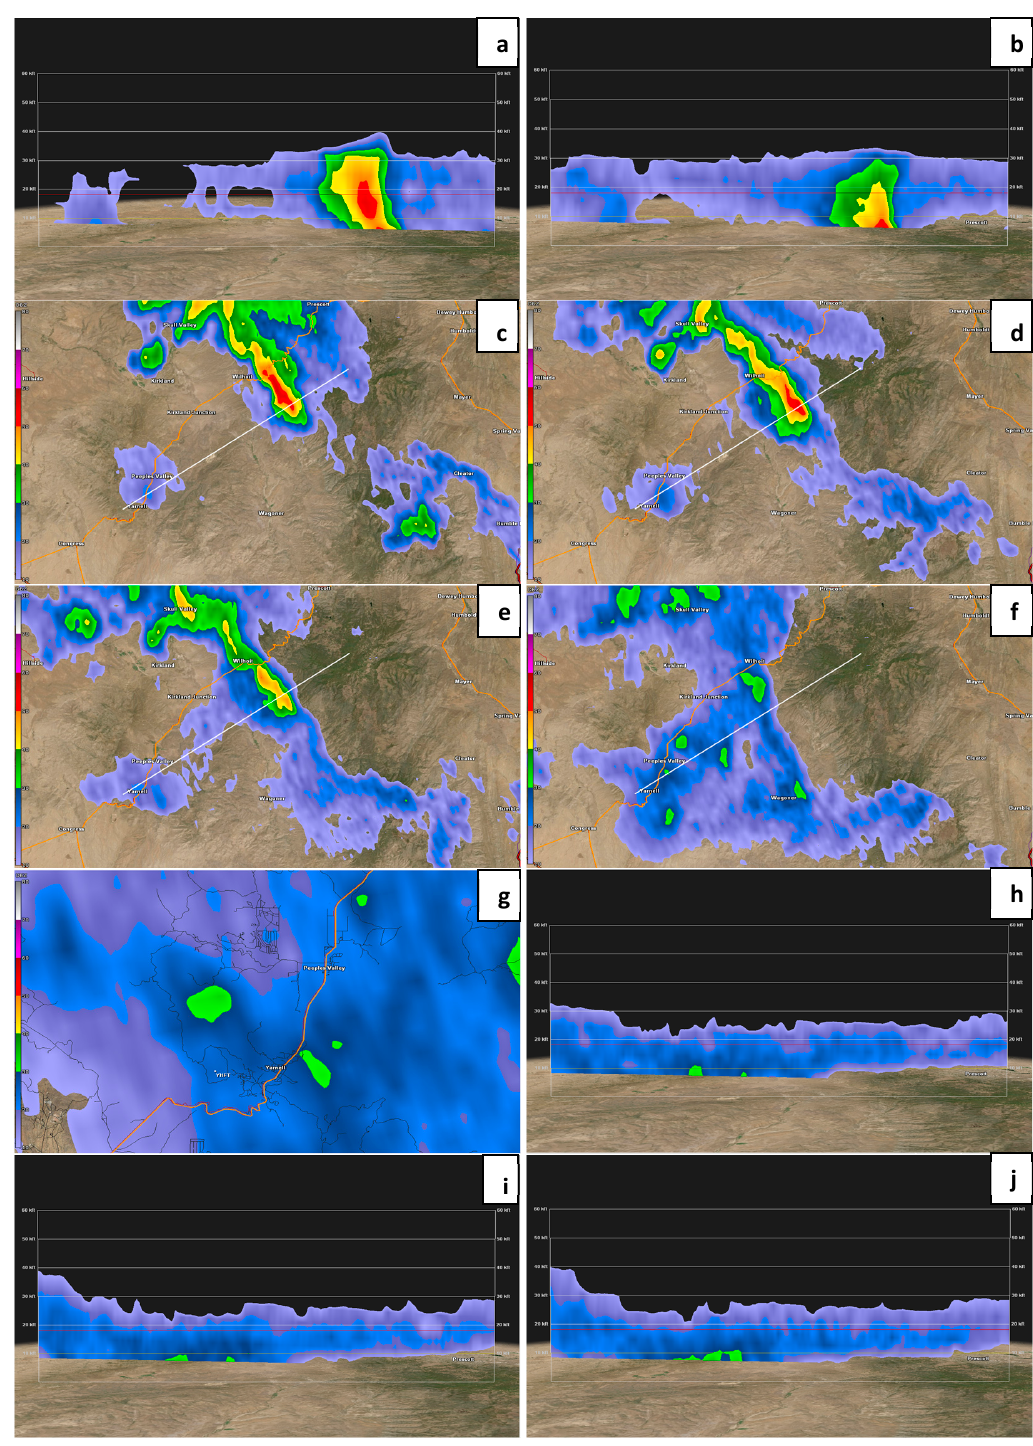
Figure 4. TFSX Doppler radar ( a , b ) vertical cross-sections of base reflectivity (dBZ) with 0.5° scan from YHFT-Spruce Mountain, AZ valid at 2247 and 2301 UTC 30 June 2013, with height above 7513 feet MSL for TFSX elevation, yellow line = 0 °C and red line = − 20 °C. ( c – f ) Horizontal cross-section of base reflectivity (dBZ) with 1° scan valid at 2247, 2301, 2311, and 2334 UTC 30 June 2013 (white cross-section for ( a , b ). ( g ) Horizontal cross-section of base reflectivity (dBZ) with 1.3° scan valid at 2335 UTC 30 June 2013 (orange line state route AZ 89). ( h – j ) Same as ( a , b ), valid at 2338, 2343, and 2348 UTC 30 June 2013 (NOAA, National Weather Service).